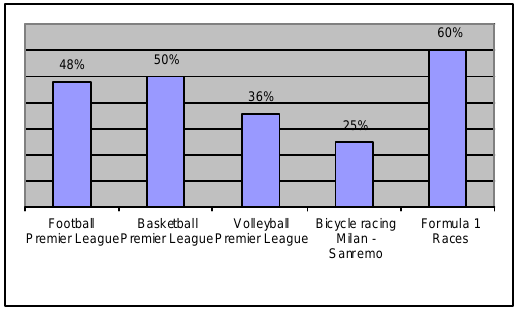
Figure 9: Spontaneous Recognition of Sponsors in Italy